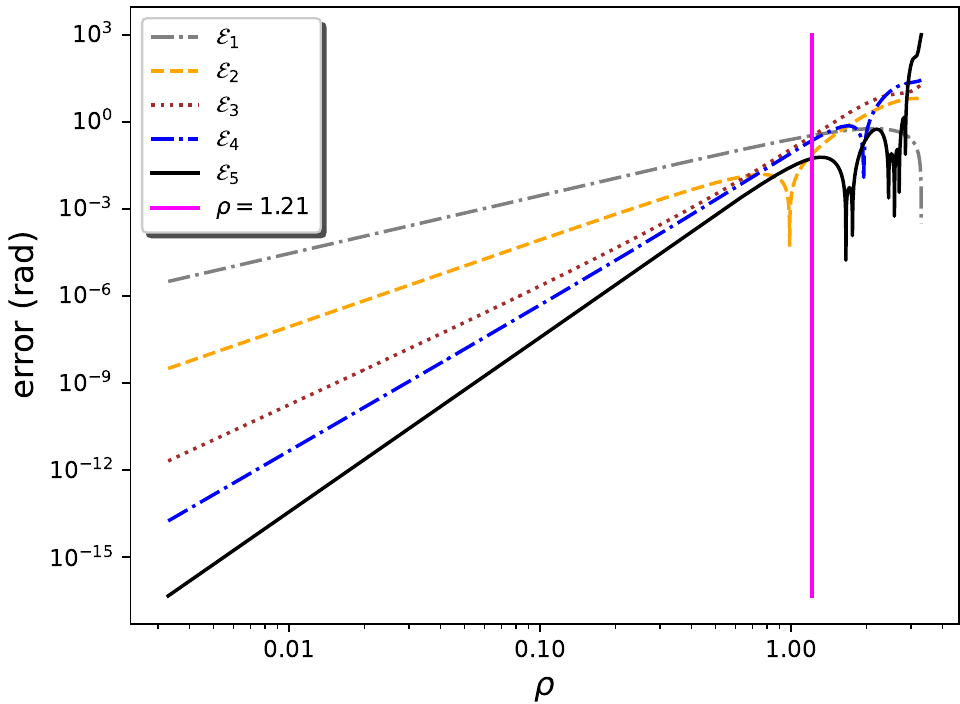
Figure 1. Errors E n ( e , M ) (in logarithmic scale) affecting the approximate polynomial solutions S n ( e , M ) of KE for ( e c , M c ) = ( 0,0 ) along the diagonal line M = π e of the ( e , M ) plane (thus √ ρ = 1 + π 2 e and tan φ = π ). The S n are obtained by truncating the infinite series of Equation (27) up to degree n , for n = 1, · · · ,5. The vertical magenta line at ρ = 1.21 corresponds to the limit below which convergence is obtained in this